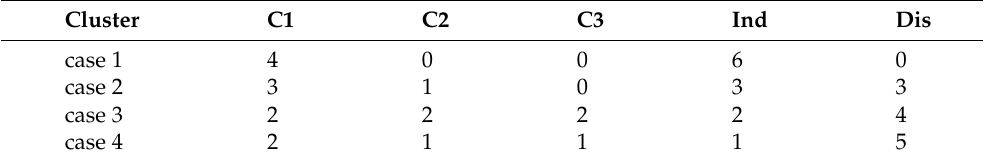
Table A2. Five possible clusterings with cluster number as three. “IND”: the number of indistin- guishable pairwise comparisons; “DIS”: the number of distinguishable pairwise comparisons. Cluster C1 C2